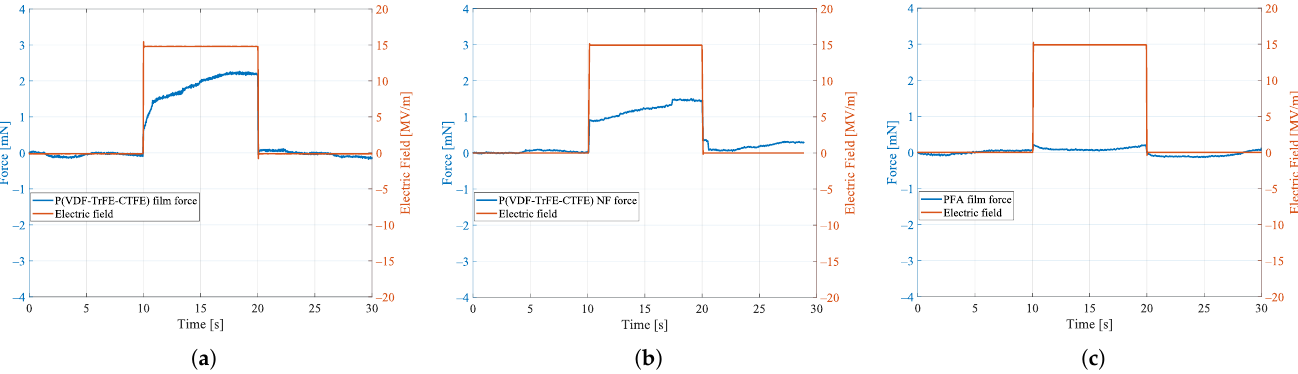
Figure 8. Contraction forces in the uniaxial load test for ( a ) the specimen of P(VDF-TrFE-CTFE) film, ( b ) the specimen of P(VDF-TrFE-CTFE) nanofibers (NF) mat, and ( c ) the specimen of PFA